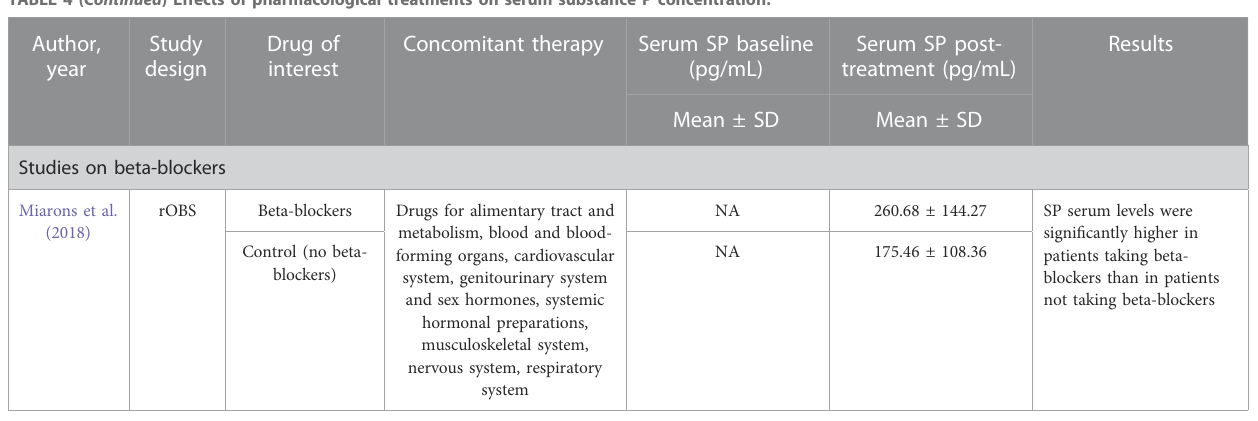
TABLE 4 ( Continued ) Effects of pharmacological treatments on serum substance P